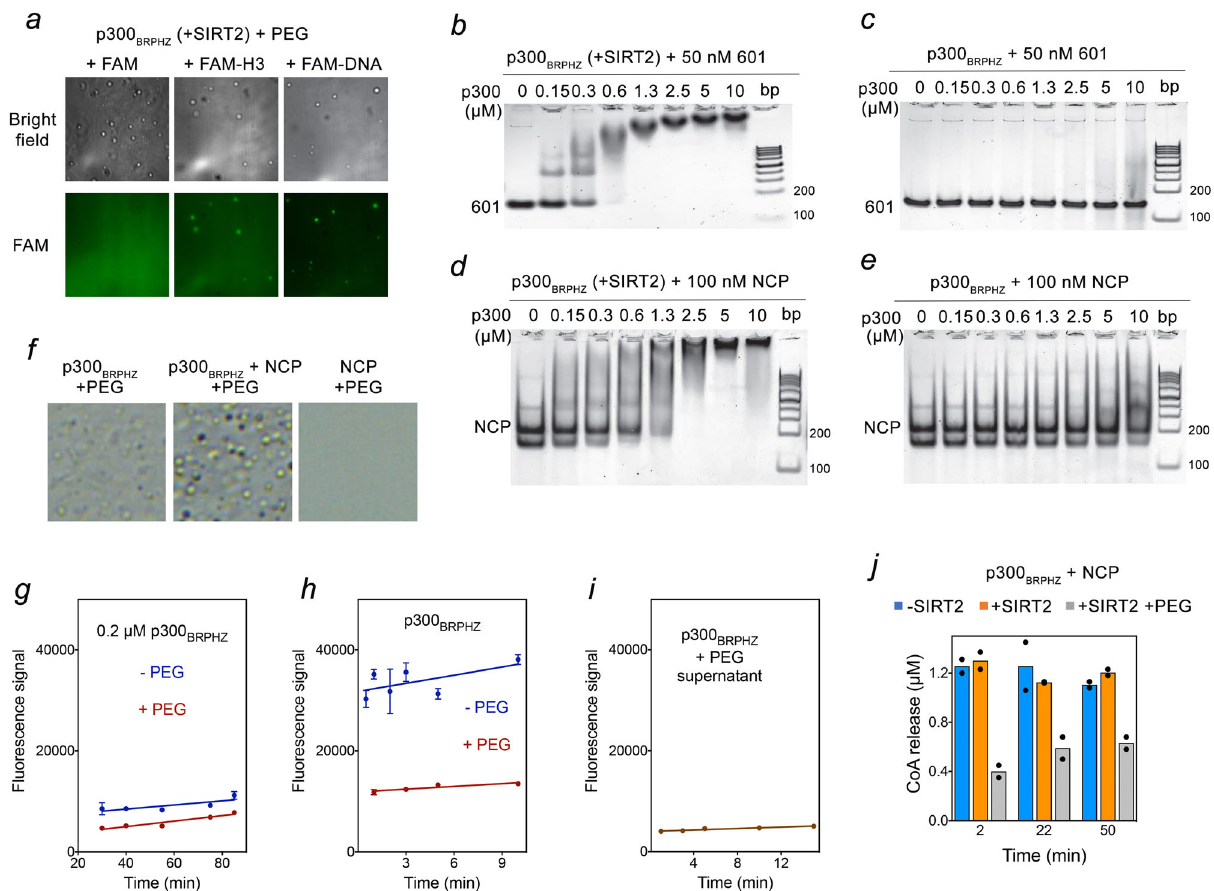
Fig. 6 Acetylation regulates the association of p300 with DNA and the nucleosome. a Representative confocal images of phase-separated SIRT2-treated p300 BRPHZ condensates with FAM control (left), FAM-labeled H3 1 – 12 peptide (middle), and FAM-labeled DNA (right). A 50 µ m × 50 µ m square region is shown for each sample. b , c EMSA of 147-bp 601 DNA incubated with increasing amounts of SIRT2-treated ( b ) and untreated ( c ) p300 BRPHZ . DNA and protein concentrations are shown above the gel image. d , e EMSA of the reconstituted nucleosome incubated with increasing amounts of SIRT2-treated ( d ) and untreated ( e ) p300 BRPHZ . Nucleosome core particle (NCP) and protein concentrations are shown above the gel image. f Phase separation of SIRT2- treated p300 BRPHZ alone (left), p300 BRPHZ incubated with NCP (middle) and NCP alone (right) in a buffer containing 12% PEG. A 50 µ m × 50 µ m square region is shown for each sample. Experiments in a – f were performed in at least two replicates. g HAT activity of diluted (0.2 μ M) ( g ) and concentrated (10 μ M) ( h ) SIRT2-deacetylated p300 fl uorometric assay. i HAT activity of SIRT2-deacetylated p300 BRPHZ ± PEG was measured by a BRPHZ in supernatant measured by a fl uorometric assay. Droplets in the phase-separated p300 BRPHZ sample were spun down for 10 min, and the supernatant was transferred to another tube. For all experiments in ( g – i ), reactions were quenched by adding 6 M guanidine hydrochloride. The relative reaction rates (slope values) are 0.020 ( − PEG) and 0.027 ( + PEG) in ( g ), 0.27 ( − PEG) and 0.09 ( + PEG) in ( h ), and 0.035 in ( i ). Data in g , h are presented as mean values± SD; error